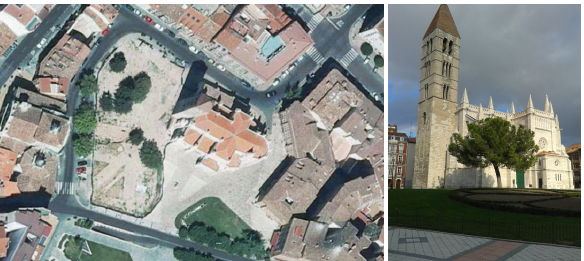
Figure 1: Aerial image taken at the time of performing the ar- chaeological excavations 1 (left) and a picture of the current state of the surveyed area (right).